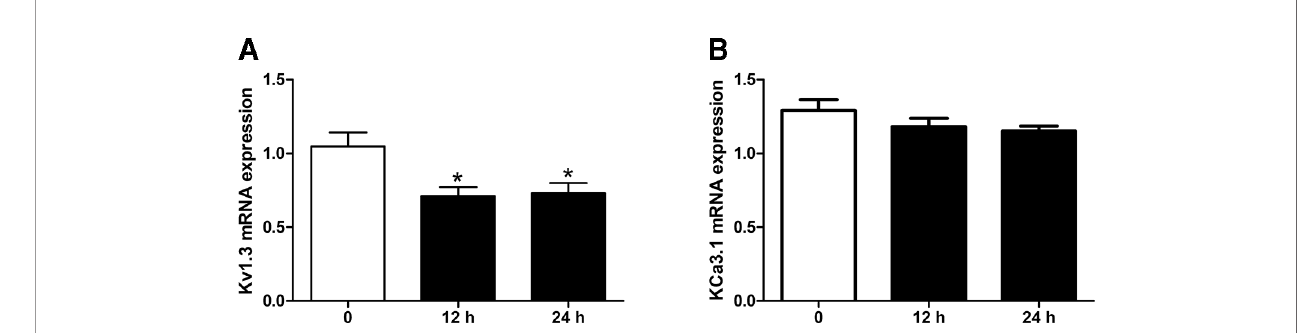
FIGURE 1 | Effects of Simvastatin on mRNA expression of Kv1.3 and KCa3.1, respectively, in monocytic THP-1 cells determined by quantitative real-time PCR. (A) Simvastatin treatment remarkably inhibited the mRNA expression level of Kv1.3 in monocyte THP-1 cells. (B) . Simvastatin treatment had no in fl uence on the mRNA expression level